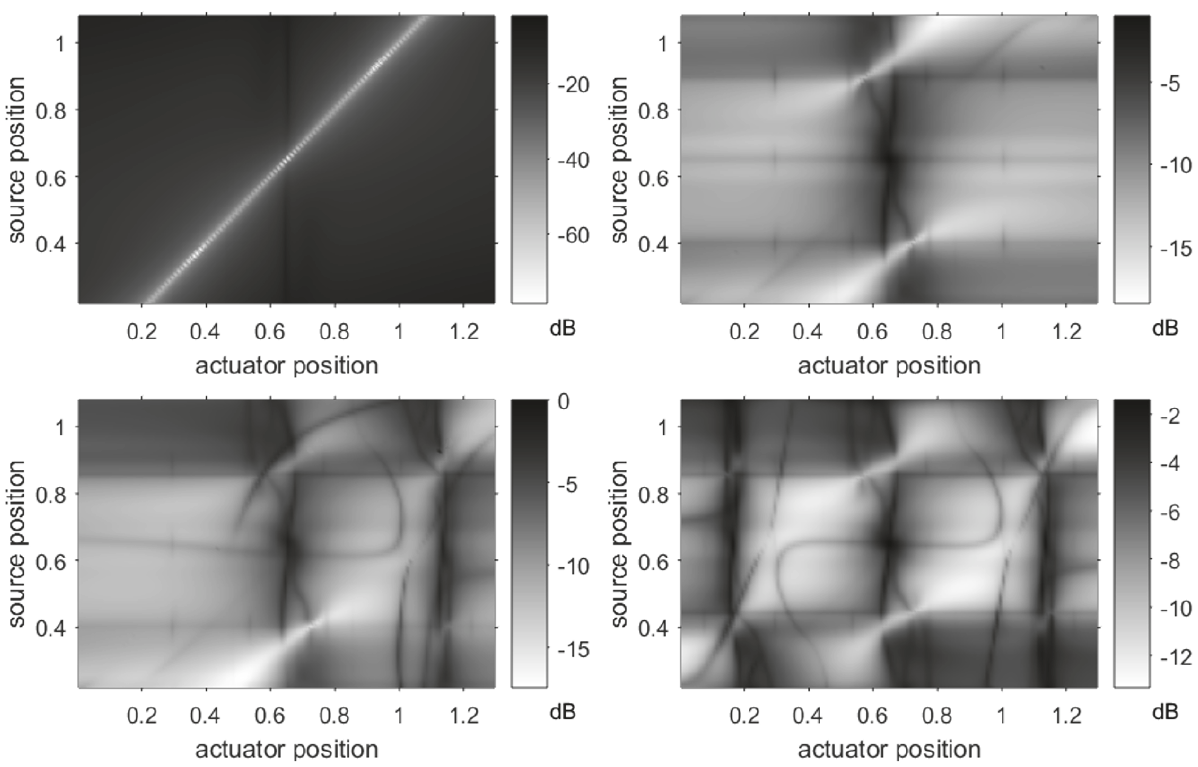
Figure11:Dropinkineticenergylevelofreceiverbeamduetoanoptimisedactivedamper.Top:clamped-clampedreceiver:left,singlemount; right, 3 mounts. Bottom: 3 mounts: left, clamped-free receiver; right, free-free receiver. RMS excitation spectrum ∝ √𝑓